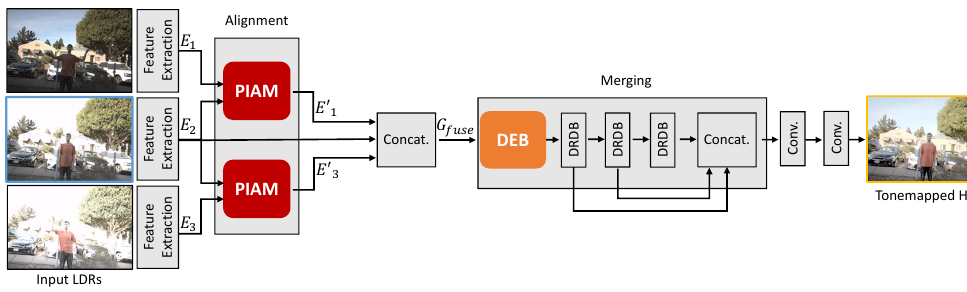
Figure 2. Overall framework for the proposed method. Our framework consists of three sections: a feature extraction network, alignment network, and merging network. First, we extract features from multiple LDR images using a feature extraction network. The alignment network, termed as pyramid inter-attention module (PIAM), is used to align the features from the feature extraction network. In the merging network, the dual excitation block (DEB) recalibrates features both spatially and channel-wise. A dilated residual dense block (DRDB) is used to learn hierarchical features for HDR imaging